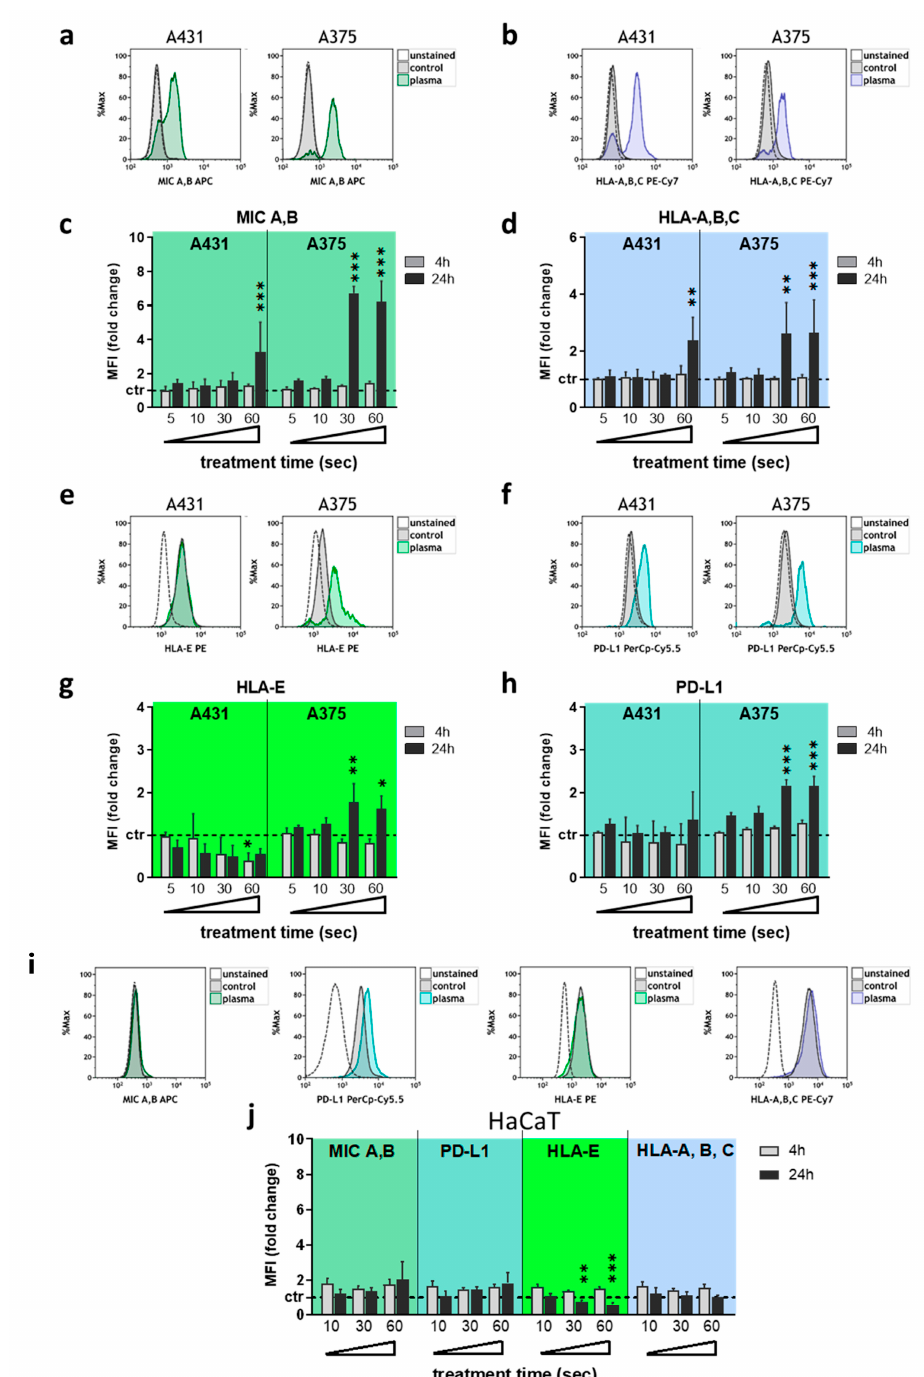
Figure 2. Plasma treatment modulated NK-cell ligand-receptor expression predominantly in malignant cells . ( a – d ) representative overlay flow cytometry histograms of MIC A,B ( a ) and HLA-A,B,C ( b ), and quantification and normalization of the MFI of MIC A,B ( c ) and HLA-A,B,C ( d ) in viable A431 and A375 cells at 4 h and 24 h after plasma treatment; ( e – h ) representative overlay flow cytometry histograms of HLA-E ( e ) and PD-L1 ( f ), and quantification and normalization of the MFI of HLA-E ( g ) and PD-L1 ( h ) in viable A431 and A375 cells at 4 h and 24 h after plasma treatment; ( i,j ) representative overlay flow cytometry histograms of MIC A,B, PD-L1, HLA-E, and HLA-A,B,C ( i ) and quantification and normalization of their corresponding MFI ( j ) in viable HaCaT cells at 4 h and 24 h after plasma treatment. Data are the mean of three independent experiments. Statistical analysis was performed using one-way ANOVA (* = p < 0.01, ** = p < 0.01, *** = p < 0.001). MFI = mean fluorescent